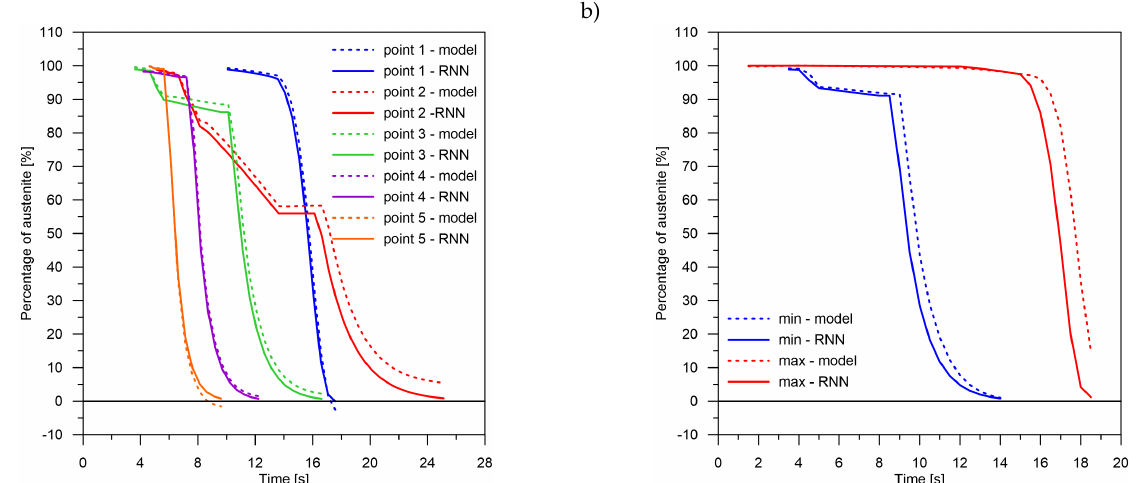
Figure 13. Kinetics of transformations: a comparison of the analytical model with the RNN model for case No.